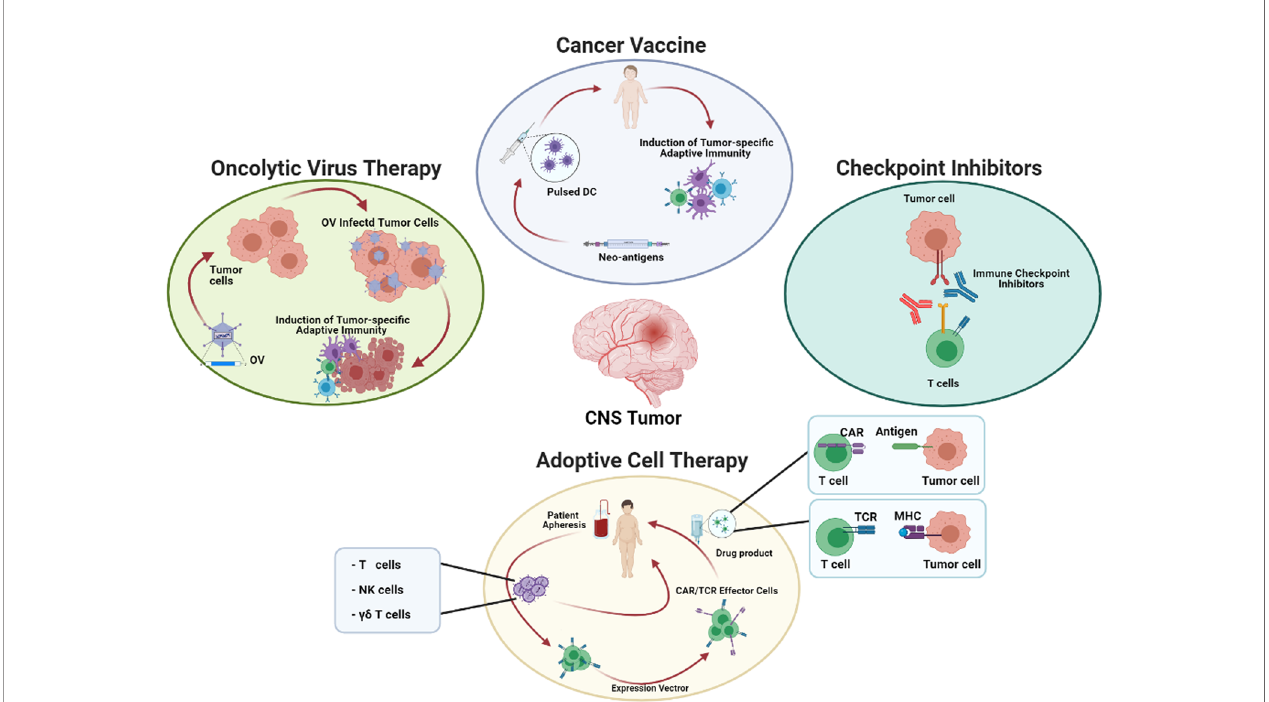
FIGURE 1 | Potential strategies for the treatment of brain tumors. The cartoon summarizes the main immunotherapeutic approaches currently used in clinical trials, subdivided in four major categories: 1) Cancer Vaccine based on Dendritic Cells (DC) pulsed with neoantigens or electropored/infected to transfer neo-antigen genes; 2) Checkpoint Inhibitors based on the use of antibody blocking relevant exhaustion pathway in T cells; 3) Adoptive Cell Therapy based on genetic modi fi cation of effector cells with expression vector for TCR or CAR; 4) Oncolytic Virus Therapy based on tumor cell infection, and the consequent activation of adaptive immunity. DC, Dendritic Cells; CAR, Chimeric Antigen Receptor; TCR, T Cell Receptor; MHC, Major histocompatibility complex; NK, Natural Killer cells; OV, Oncolytic